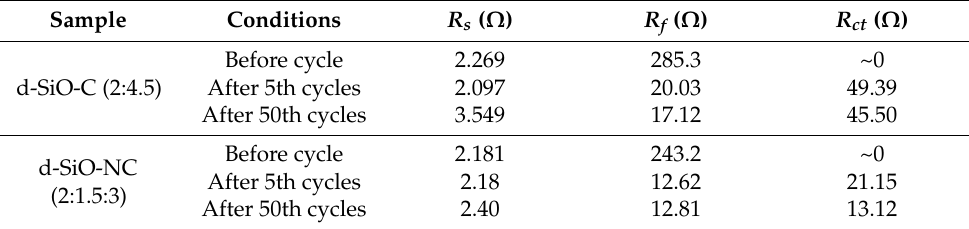
Table 2. The values of ohmic, solid electrolyte film and charge transfer of d-SiO-C (2:4.5) and d-SiO-NC